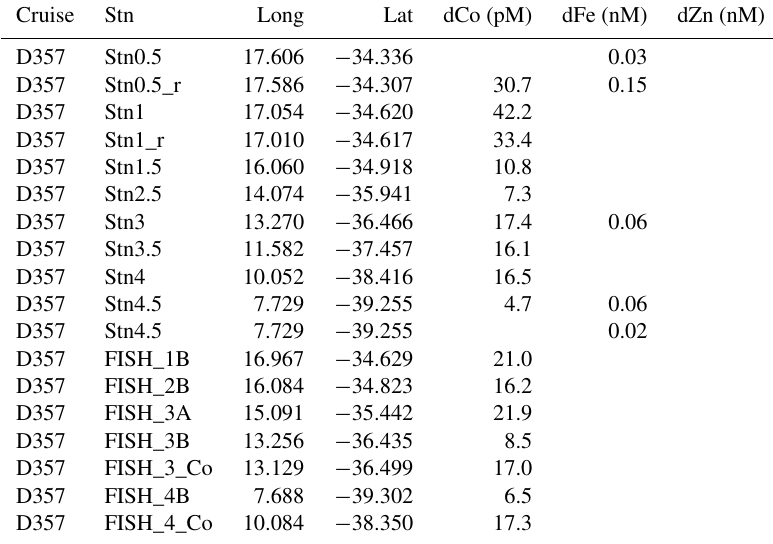
Table B1. Surface water ( < 10m) dissolved trace element